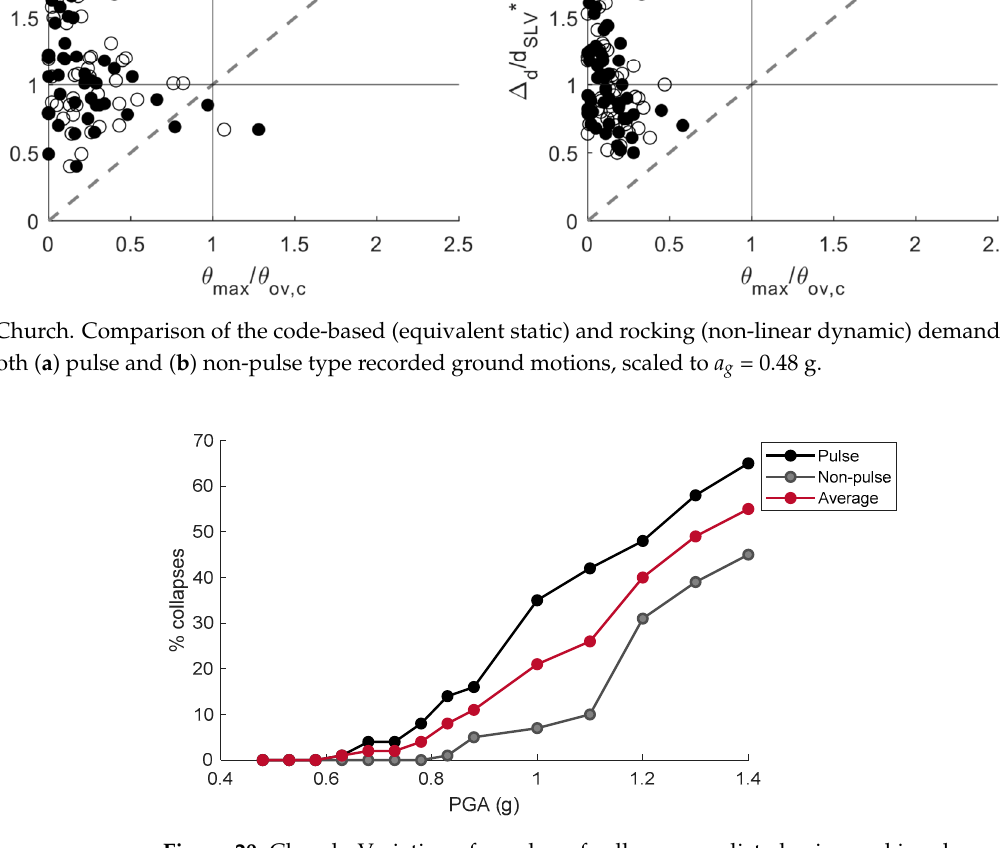
for both pulse and non-pulse type recorded ground motions.